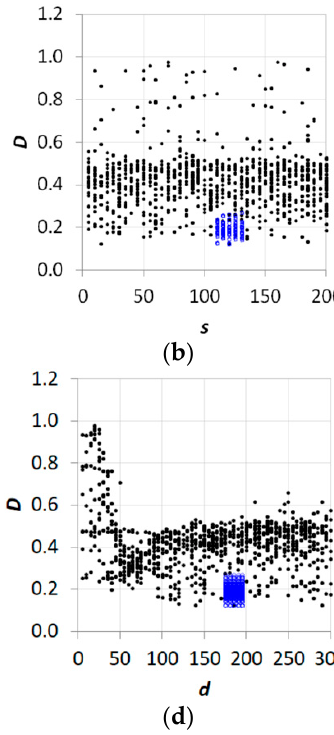
Figure 7. Segmentation parameters optimized on perimeters for the arid period: ( a ) D versus k ; ( b ) D versus p ; ( c ) D versus s; ( d ) D versus d , dispersions.